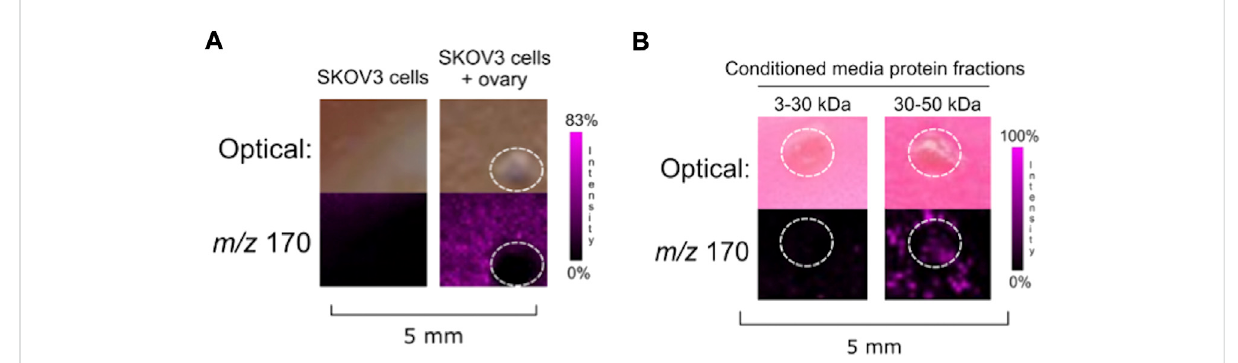
FIGURE 2 (A) Co-culture ofSKOV3cells with ovarian explantresulted inNEionization. (B) SKOV3 conditioned mediaprotein30 – 50 kDafraction induced ovarian NE release. Ovaries are circled with a white dotted line. IMS Method A was used for this fi